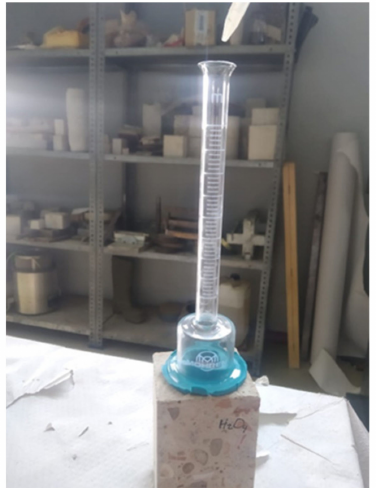
Figure 1. Concrete specimens tested by Karsten tube absorption test.